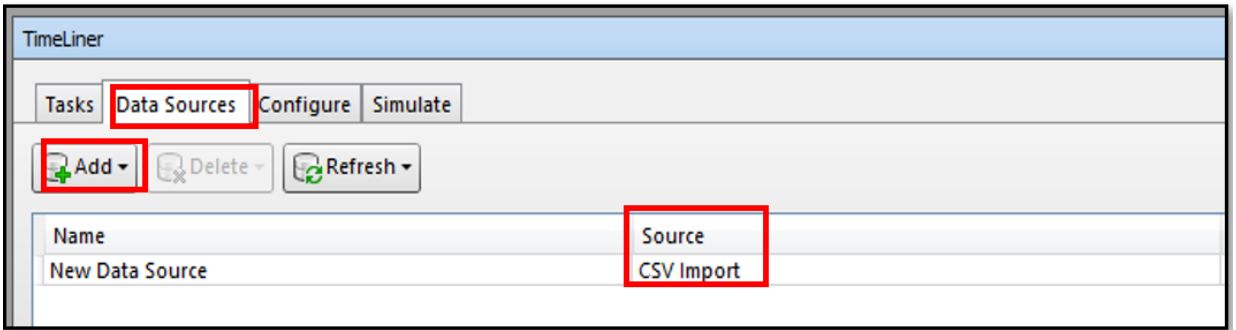
Figure 6. Preparing the .csv file.